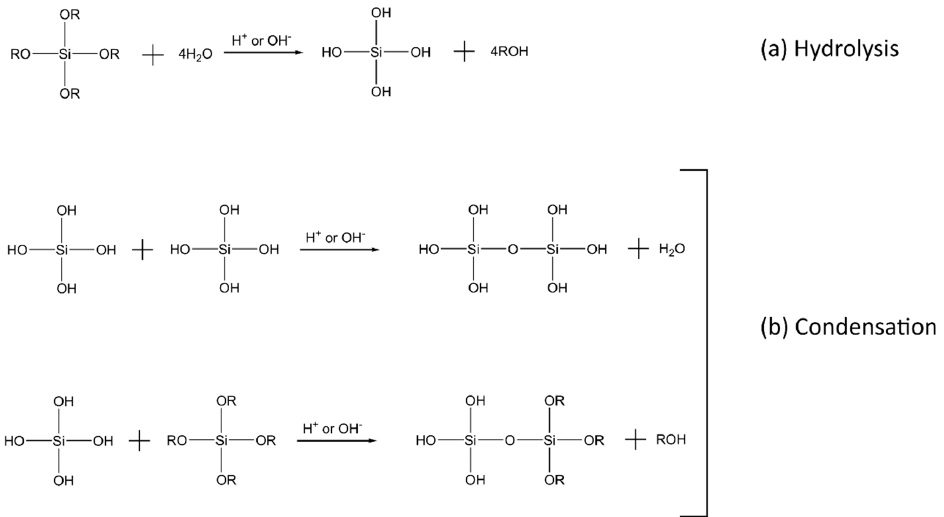
Figure 1. The ( a ) hydrolysis; and ( b ) condensation reactions of a silicon alkoxide precursor (Si(OR) 4 ) in a sol–gel process. a sol–gel